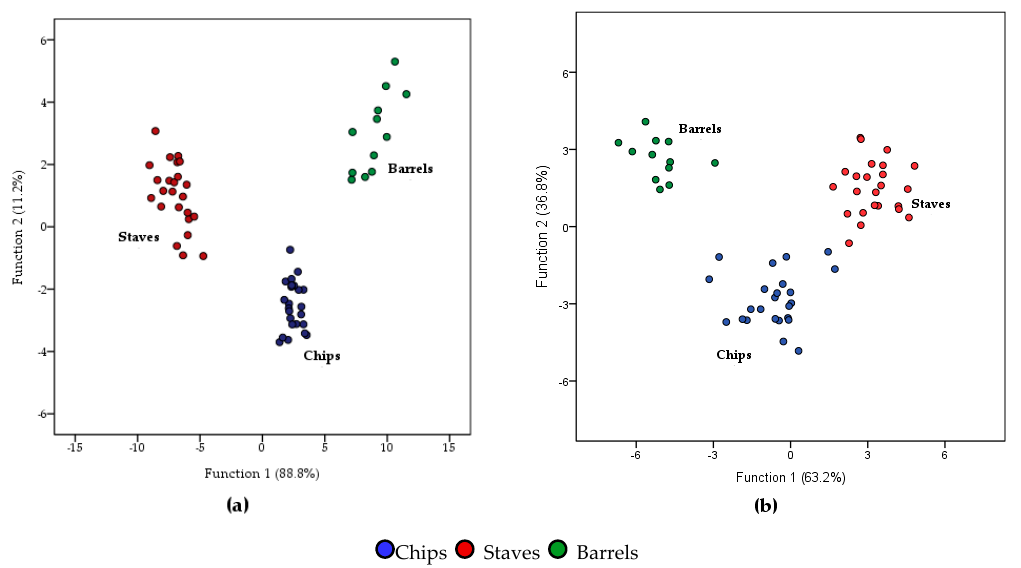
Figure 11 . Canonical discriminant analysis: ( a ) volatile composition contributed by oak wood; and ( b ) low molecular weight phenols.